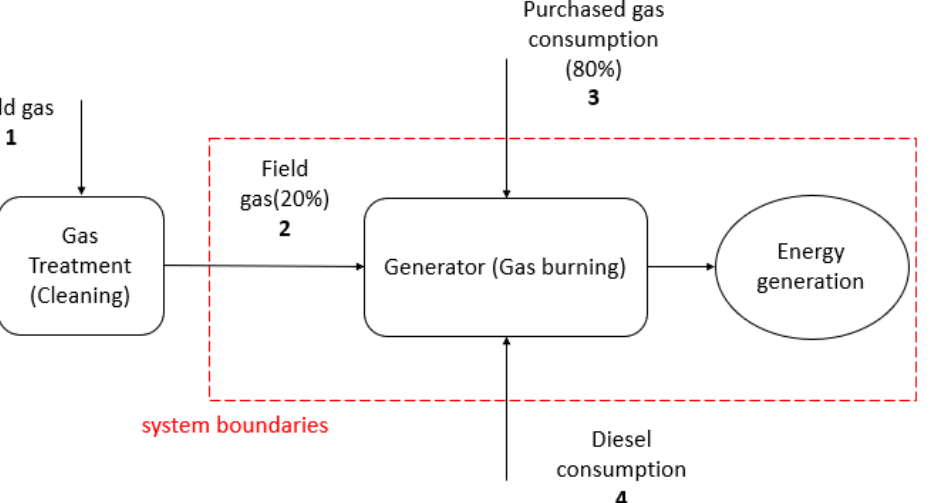
Figure 7. Energy production from non-renewable resources (gas, diesel) for both the OFA and OFB fields.